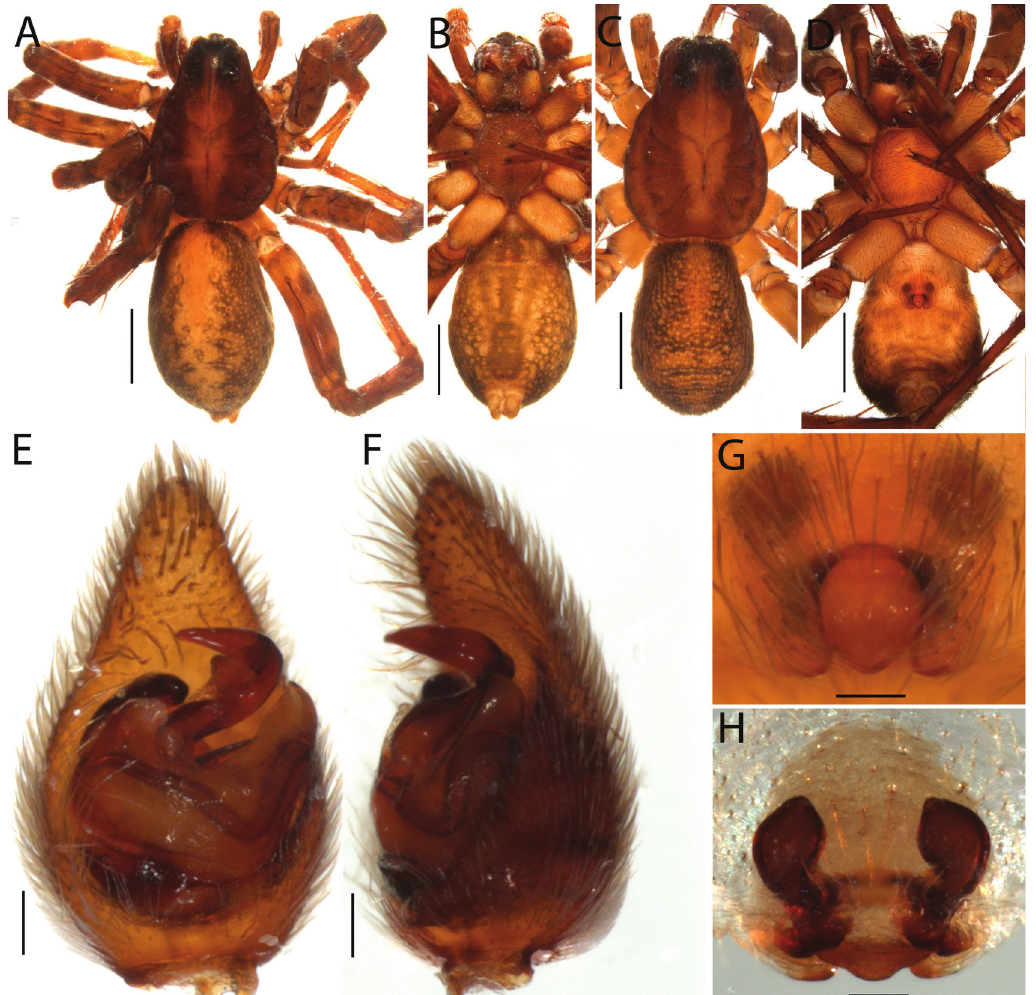
Figure 31. Artoria mckayi Framenau, 2002, male (AM KS45830), female (AM KS54476): A , male habitus, dorsal view; B , male habitus, ventral view; C , female habitus, dorsal view; D , female habitus, ventral view; E, male pedipalp, ventral view; F , male pedi- palp, retrolateral view; G , epigyne, ventral view; H , epigyne, dorsal view. Scale bars: habitus 1.0 mm; pedipalp, epigyne 0.1